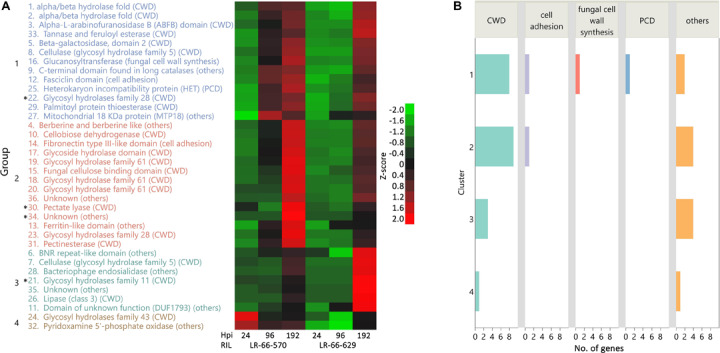
Time-course dynamics of differentially expressed Ascochyta lentis secretory genes in the two Lens ervoides RILs LR-66-629 (resistant) and LR-66-570 (susceptible). (A) Hierarchical clustering of 36 secretory genes (Ward’s method) for two RILs at 24, 96 and 192 h post inoculation (hpi). Genes with the same color are from the same group. Genes with asterisks are predicted effectors. (B) Functional classification of secreted genes among clusters.